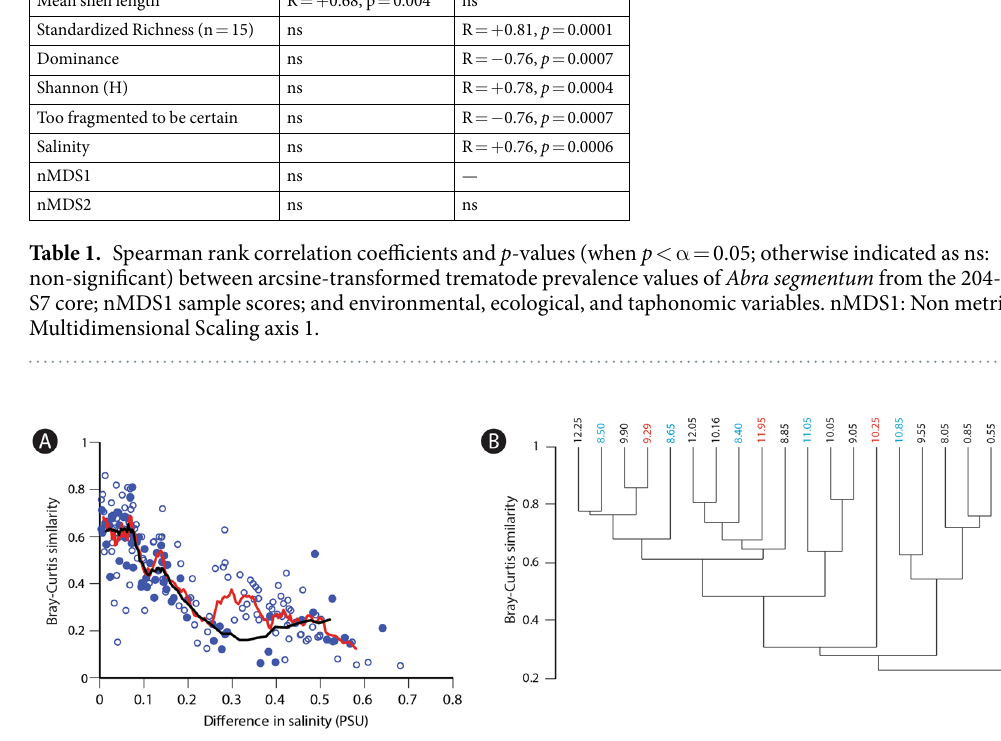
Figure 3. Turnover and ecological similarity of assemblages across core 204-S7. ( A ) Turnover estimated by pairwise comparison of Bray-Curtis similarity indices and environmental distance (nMDS1 salinity). Solid circles indicate pairwise comparisons between lagoonal muddy samples from core depths of 8.50–12.25 meters and the black line indicates the ten point running average. Hollow circles indicate all other comparisons. The red line indicates the ten point running average for all comparisons. ( B ) Q-mode cluster analysis (UPGMA algorithm, Bray-Curtis similarity). Samples with trematode prevalence values of Abra segmentum greater than and less than the 95% CI are indicated in red and blue, respectively. Note how the samples of either exceptionally low or high prevalence values are randomly distributed across the